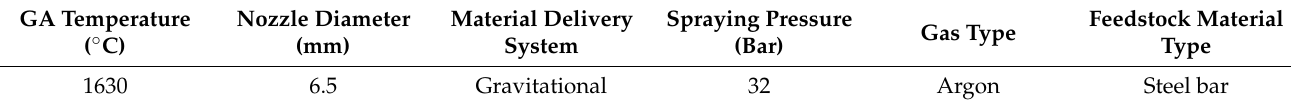
Table 1. Process parameters used in the GA.